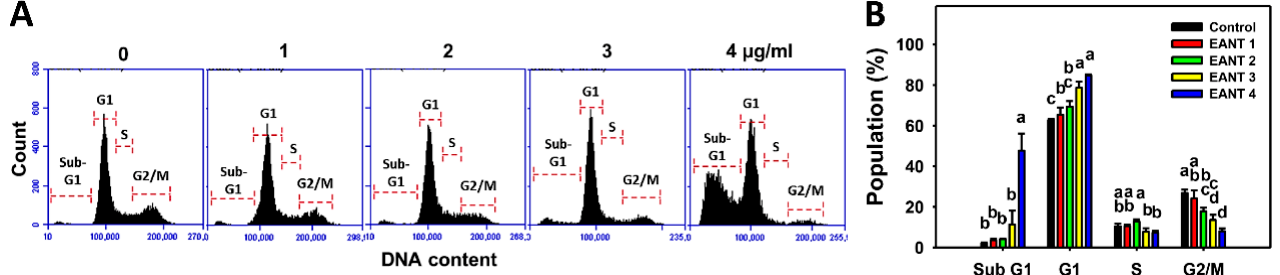
Figure 3. Cell cycle change effects of EANT-treated leukemia cells. ( A and B ) Histogram and statistical analysis for cell cycle distribution. Leukemia cells (HL-60) were treated with EANT (24 h, 0 to 4 μ g/mL). The 0 μ g/mL solution means no EANT but contains 0.1% DMSO. EANT 1, 2, 3, and 4 indicate EANT 1, 2, 3, and 4 μ g/mL, respectively. Data, means ± SD ( n = 3). Data showing different alphabets at the top reveal a significant difference ( p < 0.05–0.0001 for multiple comparisons).